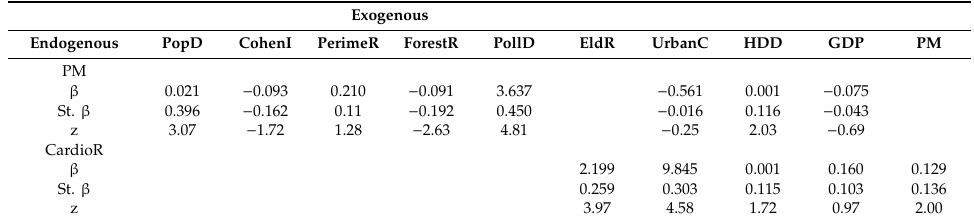
Table 3. The robust maximum likelihood estimates of unstandardized and standardized coe ffi cient.